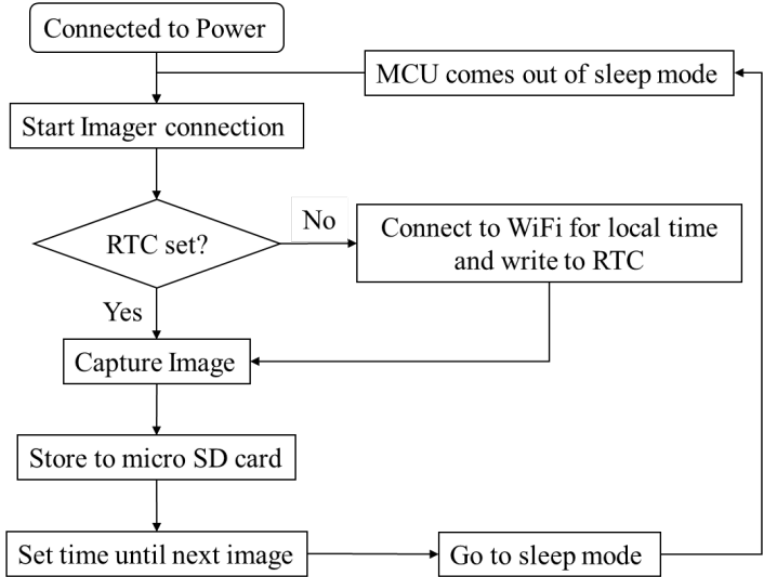
Figure 3. Functional operational flow diagram of developed remote trap monitoring system. RTC: Real Time Clock; MCU: Microcontroller unit.